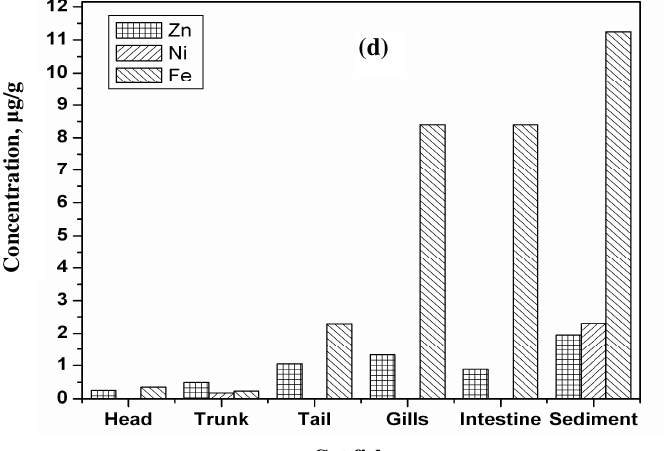
Figure 1. (a) Distribution of heavy metals in tilapia from Epe lagoon, (b) Distribution of heavy metals in tilapia from Badagry lagoon, (c) Distribution of heavy metals in catfish and sediment from Epe lagoon, (d) Distribution of heavy metals in catfish and sediment